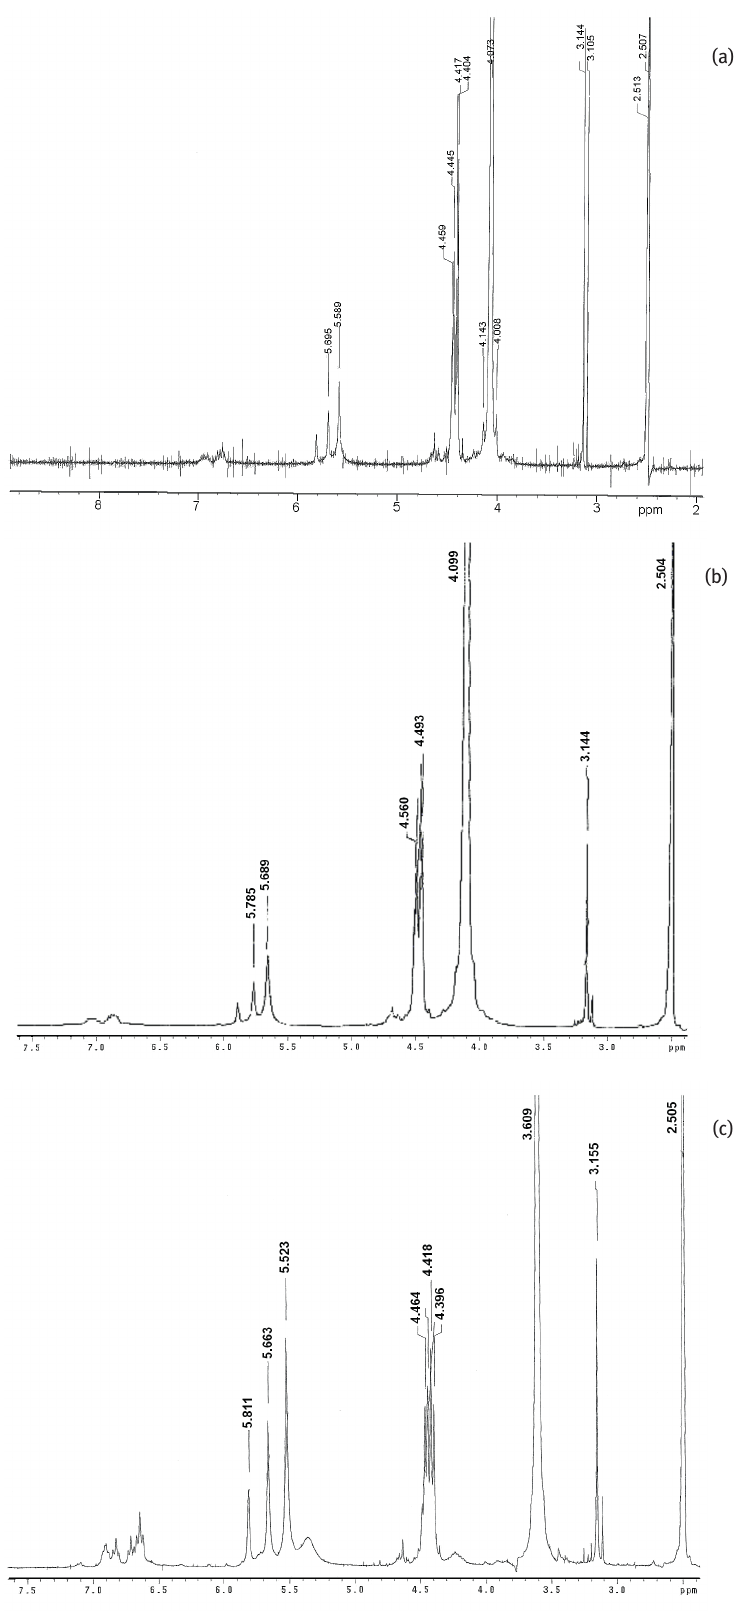
Figure 6: a) 1 H-NMR spectra of urea-formaldehyde precondensate for U/F 1/1. b) 1 H-NMR spectra of urea-formaldehyde precondensate for U/F 1.5/1. c) 1 H-NMR spectra of urea-formaldehyde precondensate for U/F